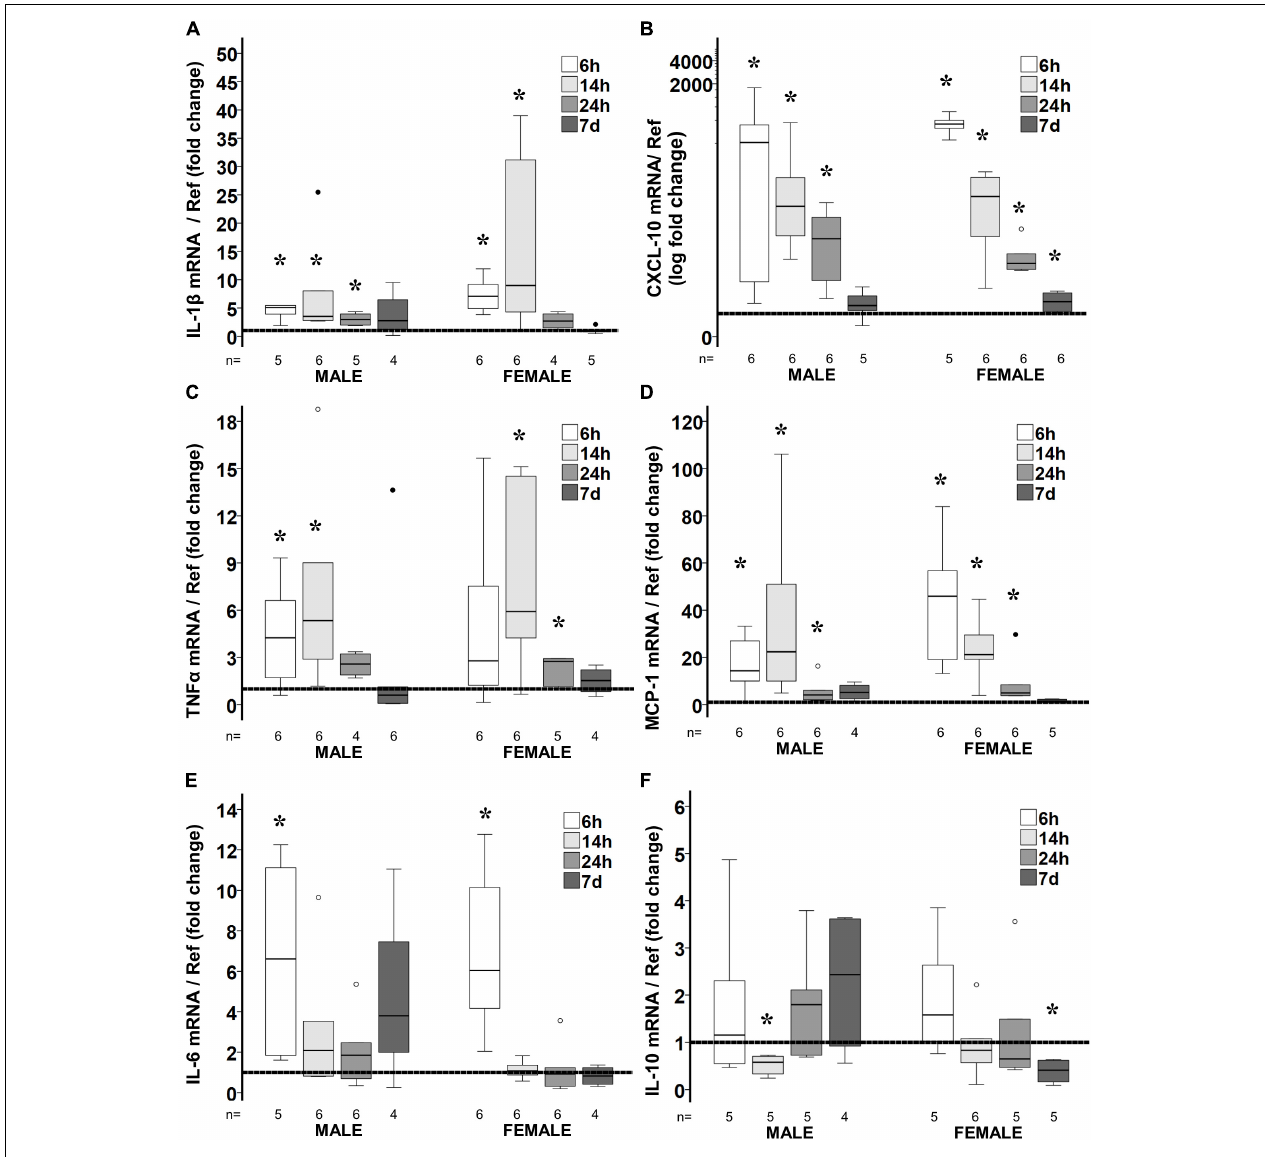
FIGURE 2 | Temporal changes in brain cytokine/ chemokine gene expression in response to poly I:C exposure at P8. Fold change in gene expression of IL-1 β (A) , CXCL-10 (B) , TNF α (C) , MCP-1 (D) , IL-6 (E) , and IL-10 (F) in the brain of poly I:C treated mice relative to NS-treated mice. Data are shown using box and whiskers plots, where boxes are limited by the 75 th and 25 th percentiles (IQR) and whiskers are limited by the last data point within 1.5 times the IQR from the median (continuous line inside the box). Data from male and female mice at 6, 14, 24 h and 7 days after poly I:C relative to NS-treated mice (discontinuous line sitting at 1) is shown. ◦ , outlier (between 1.5 and 3 times the IQR); • , extreme ( > 3 times the IQR); ∗ p < 0.05.